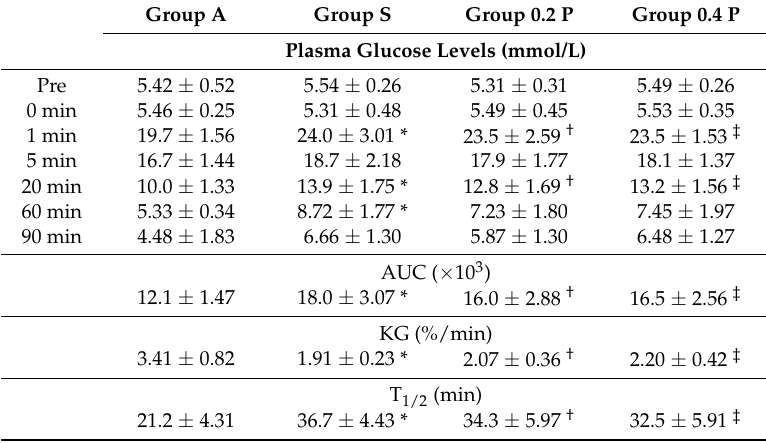
Table 1. Changes in glucose concentrations after the glucose challenge, the area under the curve, the glucose disappearance rate (KG), and the half-life of plasma glucose (T 1/2 ). Pre (before anesthesia induction): each time point indicates the elapsed time after the glucose challenge; 0 min means just before the glucose injection. Data are expressed as mean ±